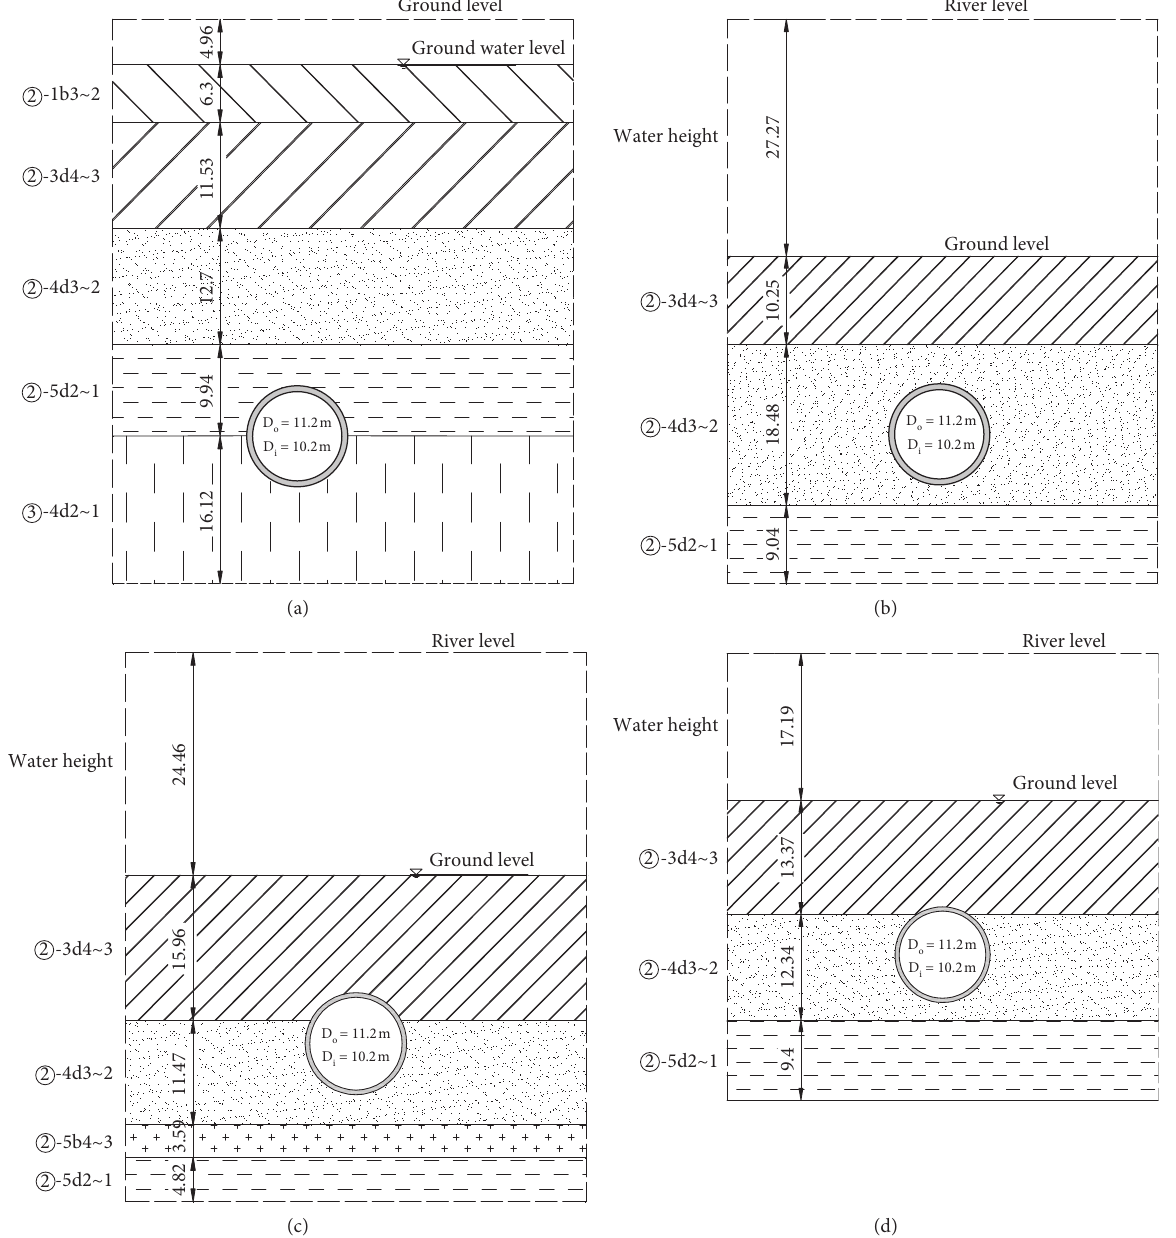
Figure 3: Geological profile of the monitoring sections: (a) Section-a (ring 479), (b) Section-b (ring 1094), (c) Section-c (ring 1210), and (d) Section-d (ring 1384).